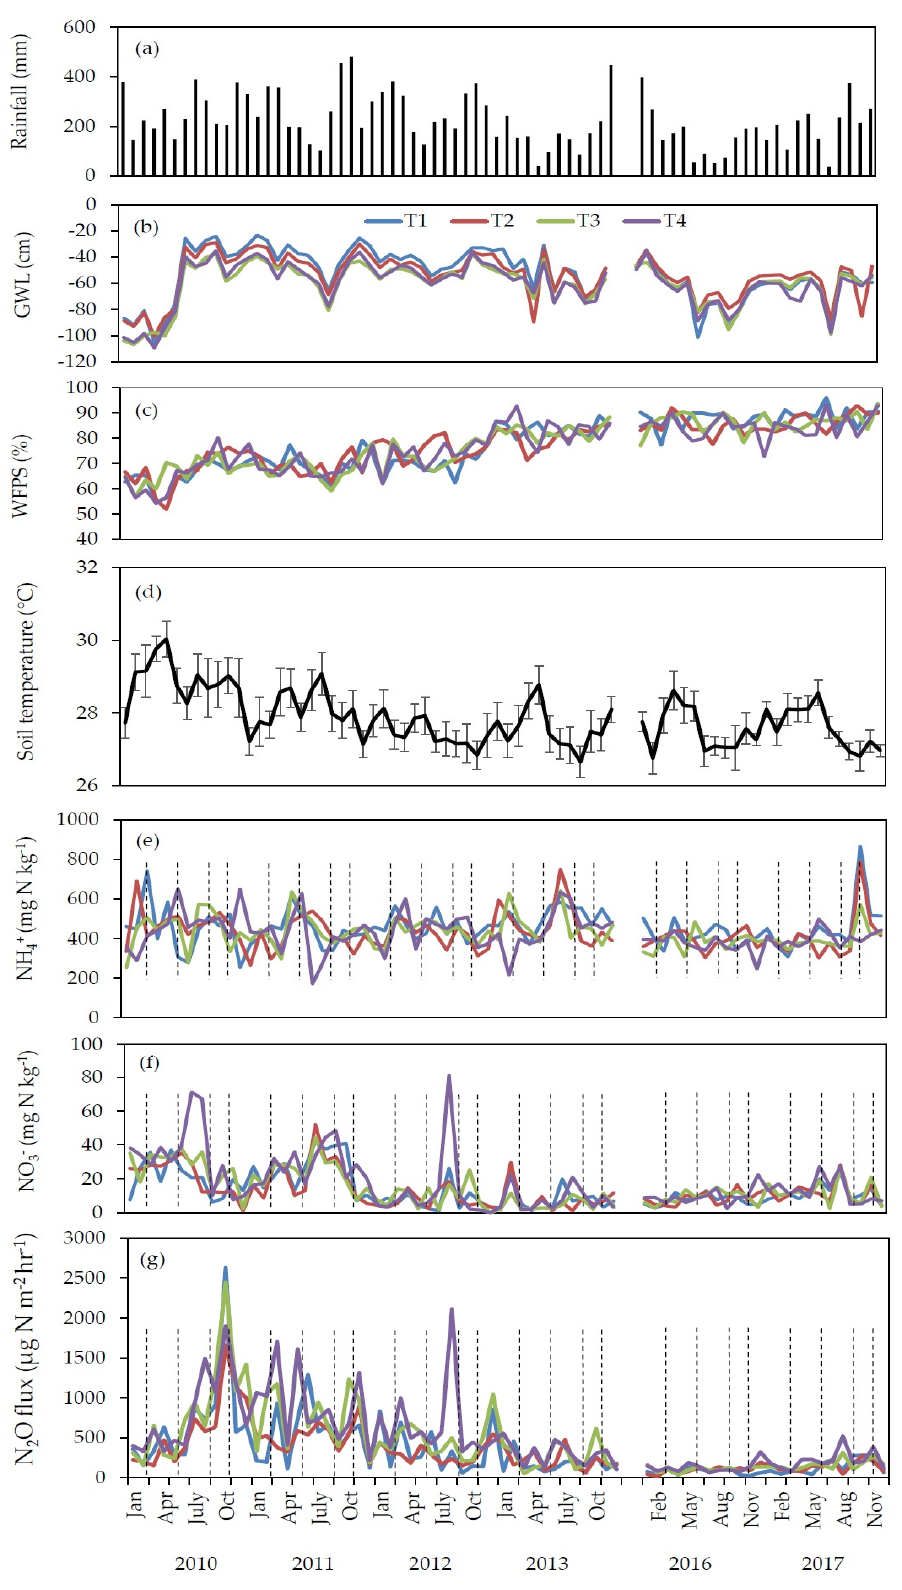
Figure 2. Monthly ( a ) rainfall, ( b ) GWL, ( c ) WFPS, ( d ) soil temperature, ( e ) NH 4 + -N, ( f ) NO 3 − -N concentrations and ( g ) N 2 O fluxes for each treatment. The dashed line indicates N fertilization (applied every March, June, September, and November of each year).